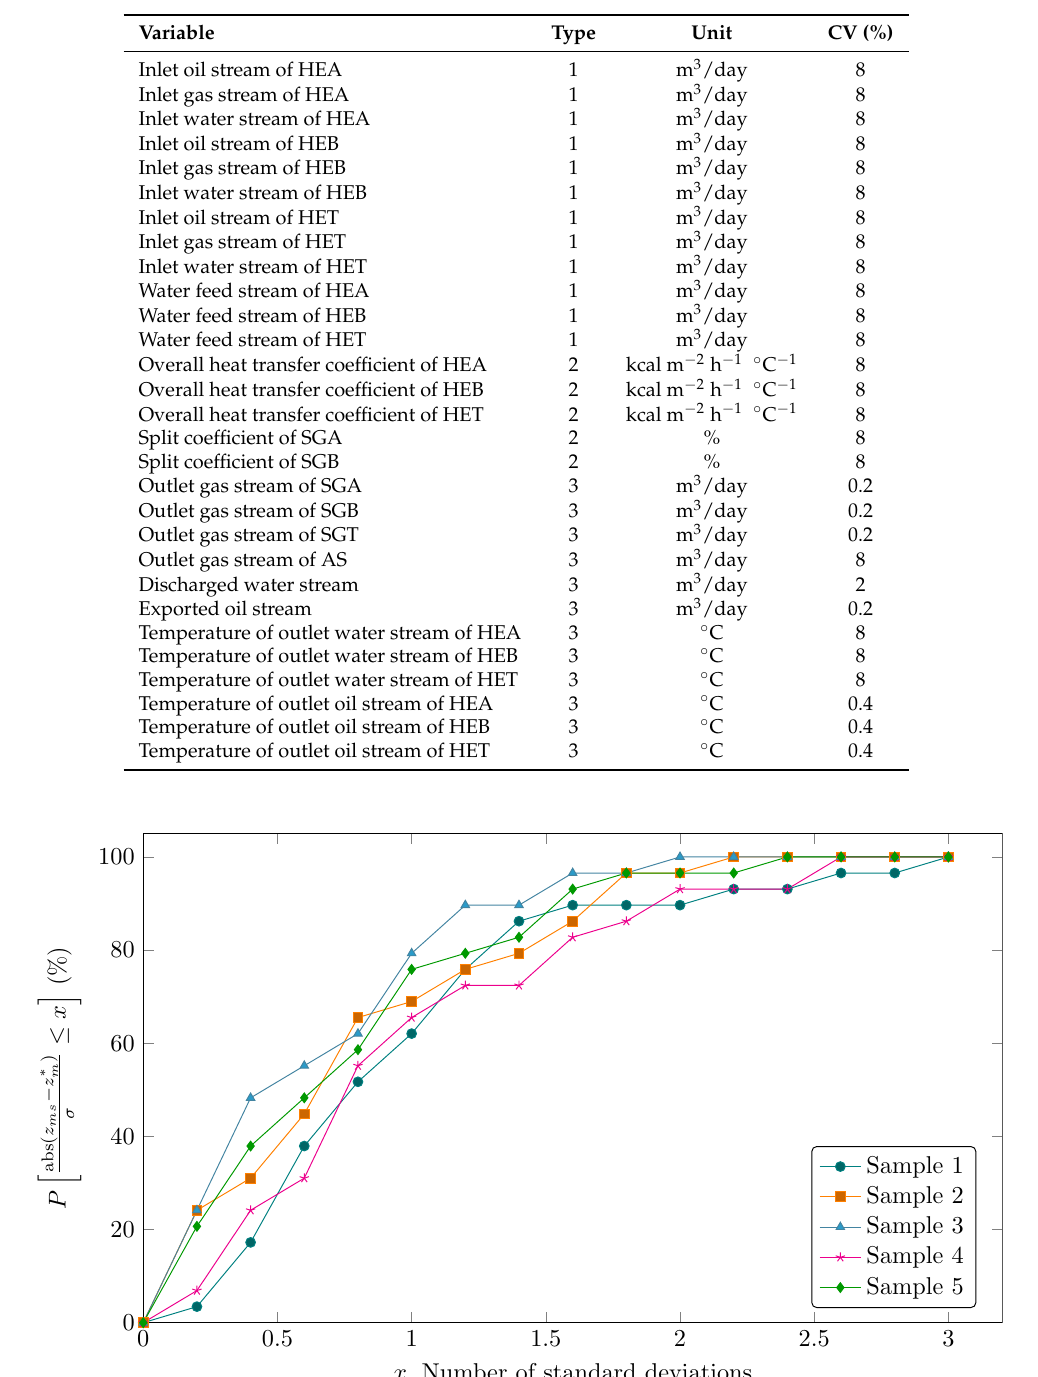
Table 2. Information regarding process model variables and parameters.